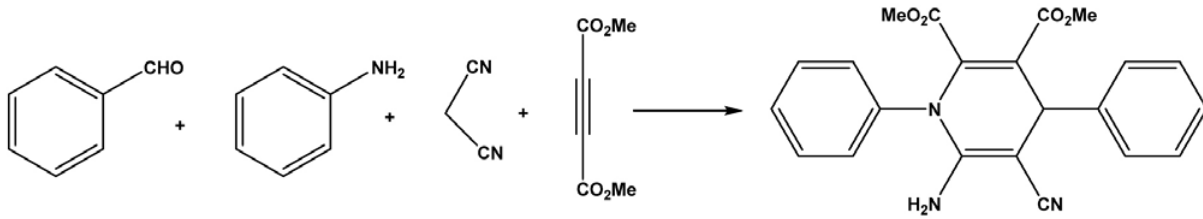
Table 1. Yields and reaction times for the preparation of 1,4-dihy- dropyridine 5a in the presence of various catalysts. a Entry Catalyst Time (h) Yield (%)